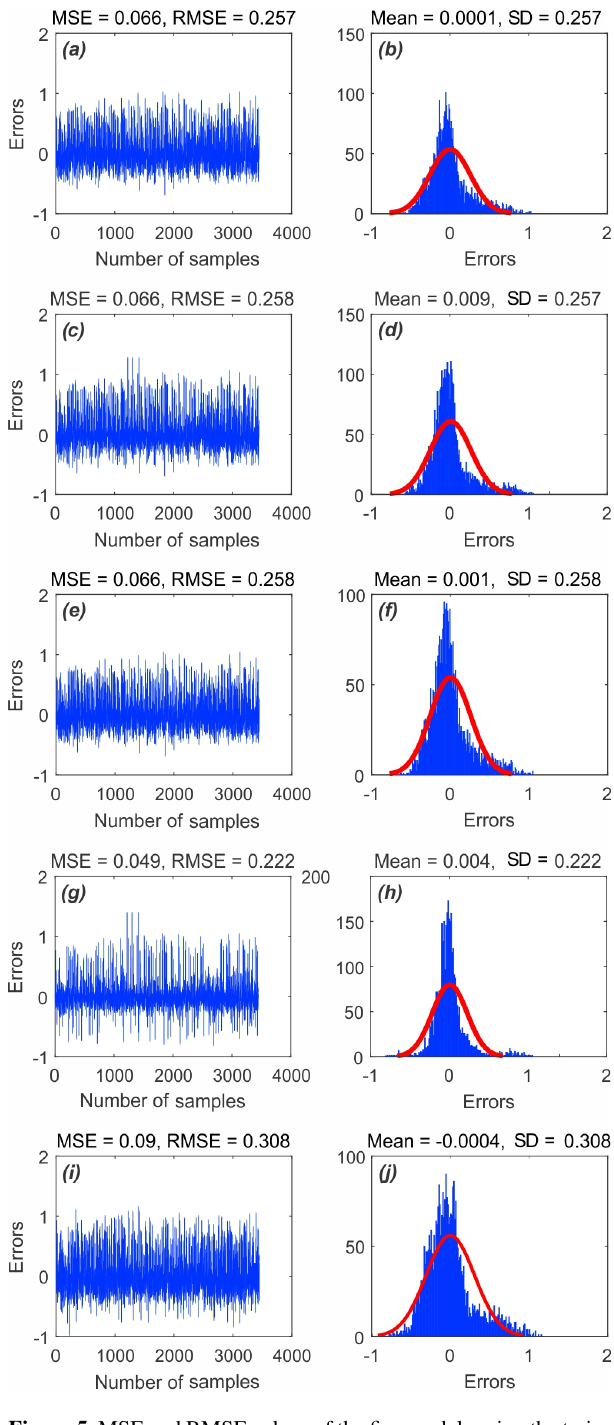
Figure 5. MSE and RMSE values of the five models using the train- ing dataset of (a) ANFIS–IWO, (c) ANFIS–DE, (e) ANFIS–FA, (g) ANFIS–PSO, and (i) ANFIS–BA. Frequency errors of the five models using the train dataset of (b) ANFIS–IWO, (d) ANFIS–DE, (f) ANFIS–FA, (h) ANFIS–PSO, and (j)